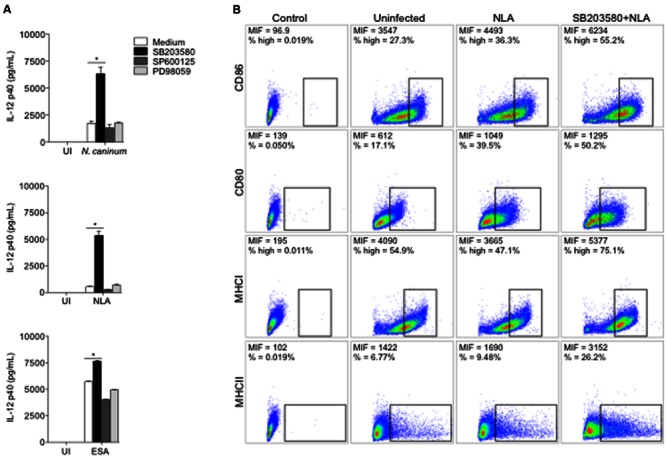
Neospora-induced p38 activation downregulates the production of IL-12 and the expression of antigen presentation molecules. BMDMs (1 × 106 cells/mL) were pretreated for 3 h with p38 inhibitor (SB203580, 10 μM), SAPK/JNK inhibitor (SP600125, 10 μM), ERK1/2 inhibitor (PD98059, 10 μM). (A) Cells were infected with N. caninum Nc-1 strain (Nc; 1:1 parasite to cell ratio) or stimulated with NLA (10 μg/mL) or ESA (10 μg/mL) or medium alone (UI). After 24 h, supernatants were collected and analyzed for IL-12p40 concentration. Results were expressed as mean ± SEM. ∗Indicates statistically significant differences between untreated cells and SB203580-treated cells, upon antigenic stimulation; P < 0.05, assessed by ANOVA followed by Bonferroni multiple comparison post-test to examine all possible pairwise comparisons. Results are representative of at least five independent experiments, with five technical replicates each. (B) BMDMs were stimulated with NLA (10 μg/mL) for 24 h and then checked for population positivity (%) and mean intensity of fluorescence (MIF) of surface markers CD80, CD86, MHCI, and MHCII. Results are representative of two independent experiments, with three technical replicates each, and dot plots were represented as percentage of positives cells, where warmer colors indicate higher cell densities.